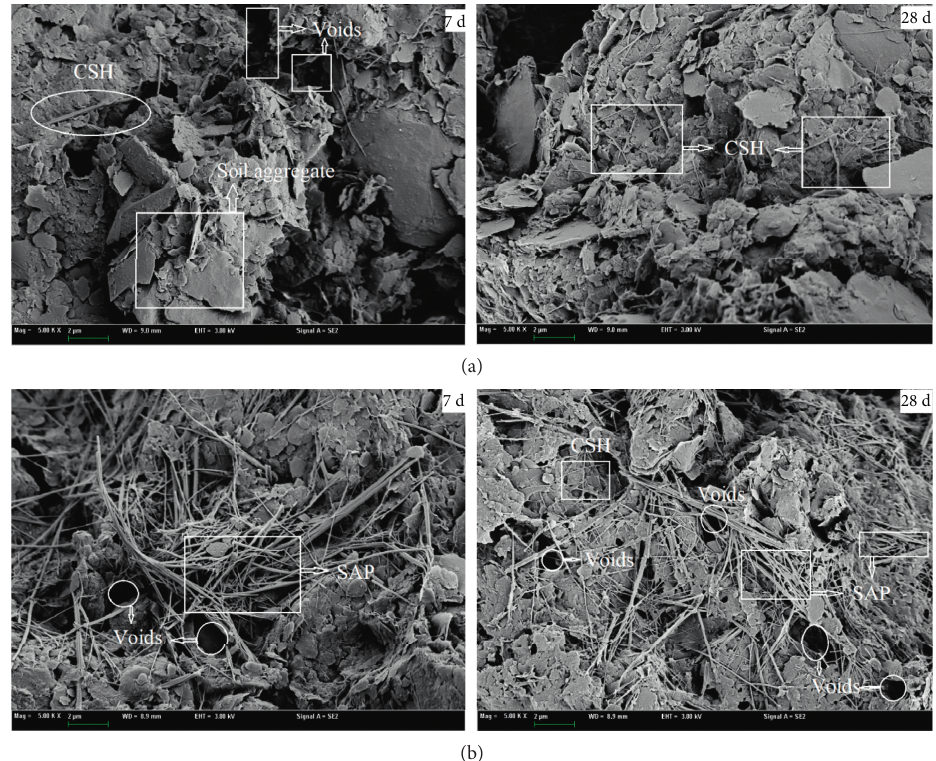
Figure 11: Scanning electron microscope images of the symbol without lime. (a) SEM images of C4. (b) SEM images of C4S30.